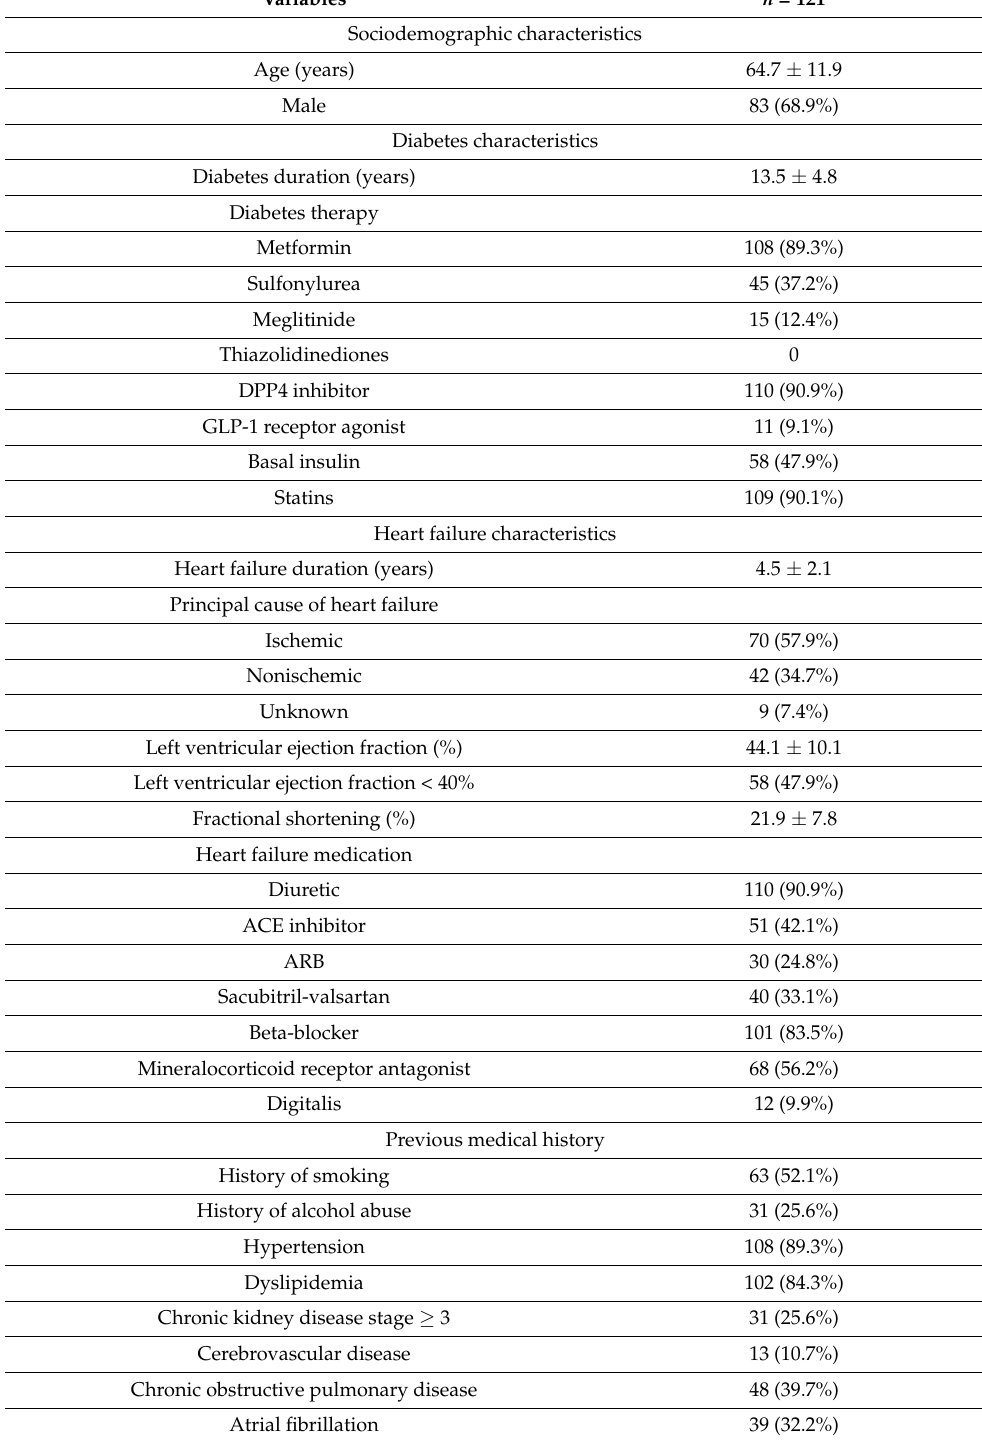
Table 1. Baseline sociodemographic and clinical-therapeutic